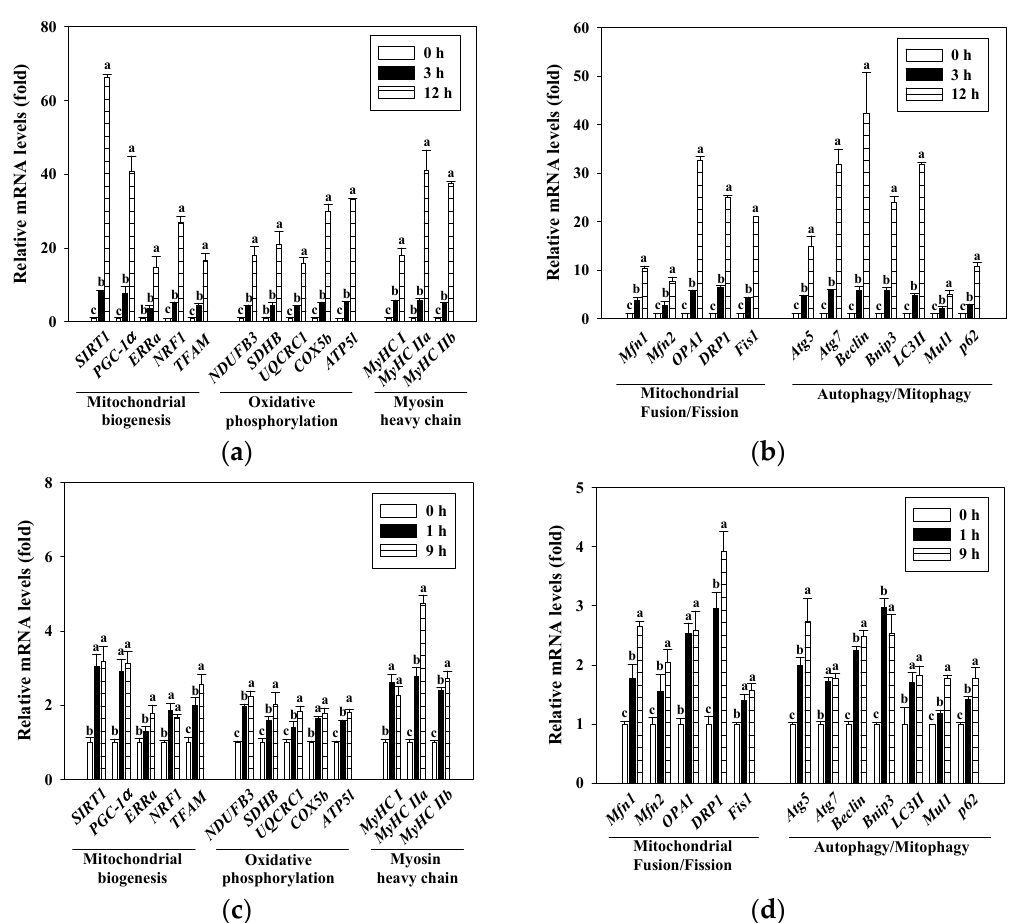
Figure 4. Effects of gallic acid ( a , b ) and rutin ( c , d ) on gene expressions of mitochondrial biogenesis, oxidative phosphorylation, myosin heavy chain, mitochondrial fusion/fission, and autophagy/mitophagy in C2C12 myotubes. C2C12 myotubes were incubated with 25 μ M of gallic acid (3 and 12 h) or rutin (1 and 9 h) at 37 ° C in a humidified 5% CO 2 incubator. The reported values are the means ± SD ( n = 3). Mean values with different letters were significantly different ( p < 0.05).